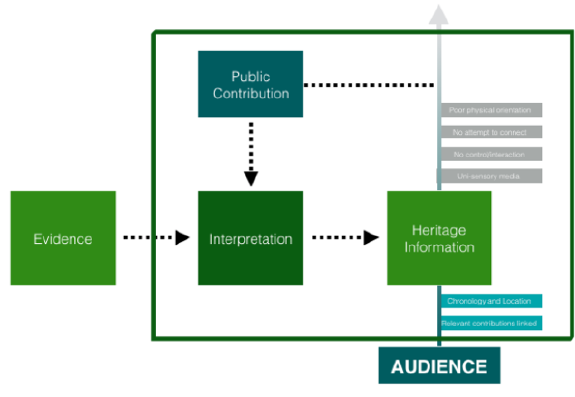
Figure 10. SMP Information Flow